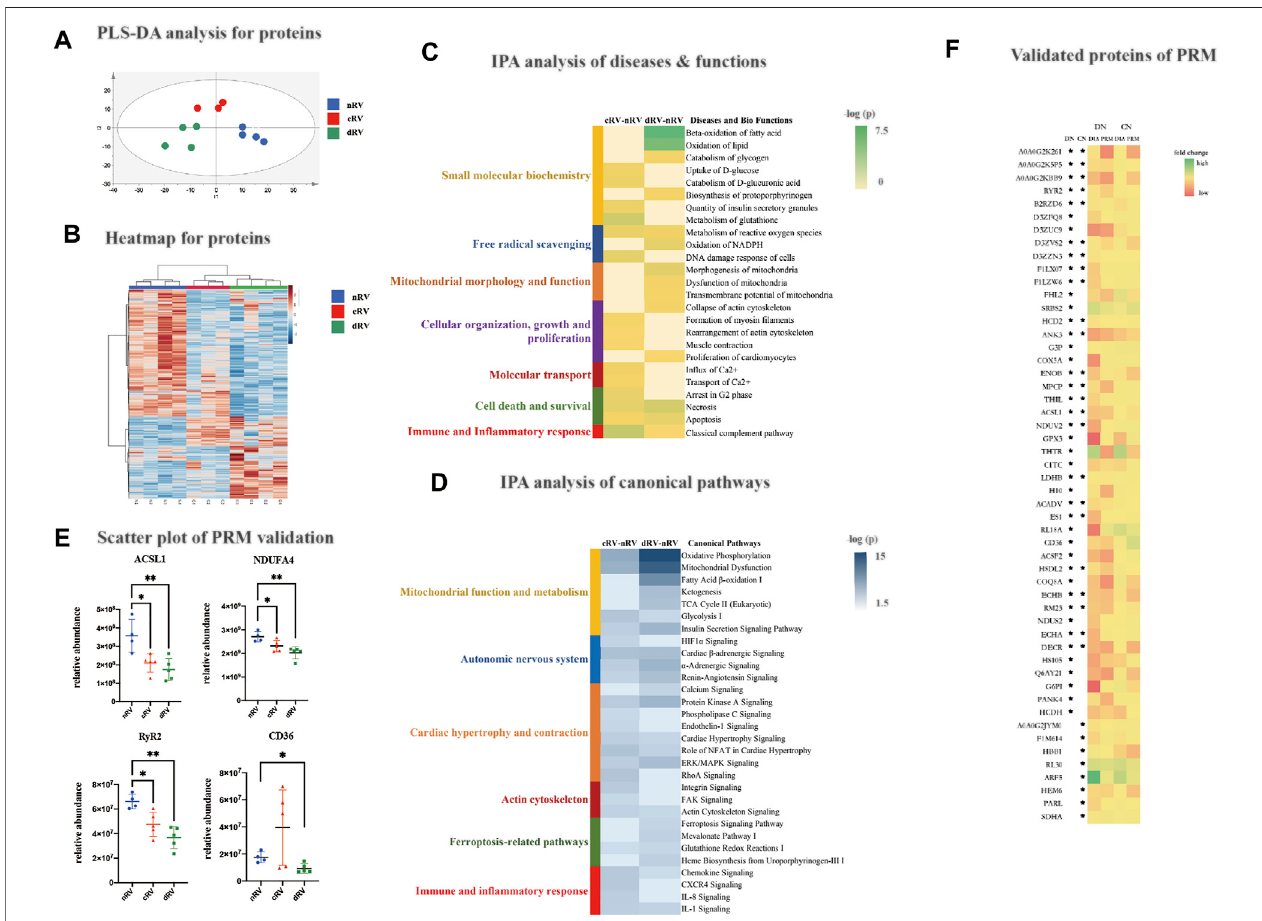
FIGURE 3 | RVF proteomic analysis of the present study. (A) The partial least squares discriminant analysis (PLSDA) score plot based on the DIA data of the myocardial proteome from nRV rats (blue), cRV rats (red), and dRV rats (green). (B) The hierarchical clustering based on the quanti fi cation of differentially expressed proteins (DEPs) among different stages. (C) The hierarchical clustering based on the p -value of functions from IPA annotation. (D) The hierarchical clustering based on the p -value of canonical pathways from IPA annotation. (E) The scatterplots of four major DEPs ’ relative abundance based on the PRM validation. (F) A color histogrambasedon thefoldchangeinthe DIAand PRMmodes ofthe validatedproteins.*Theprotein thatwassigni fi cantly altered inthecorrespondinggroup. CN,the comparison group of cRV and nRV (cRV/nRV); DN, the comparison group of dRV and nRV (dRV/nRV).